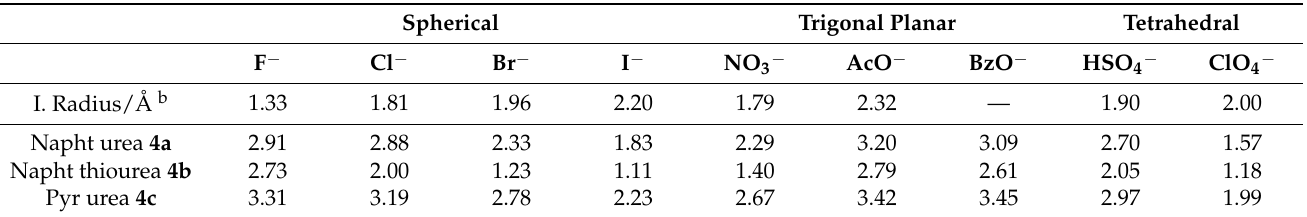
Table 1. Association constants (log K ass ) a of hexahomotrioxa (thio)ureas 4a–4c determined by 1 H NMR in CDCl 3 at 25 ◦